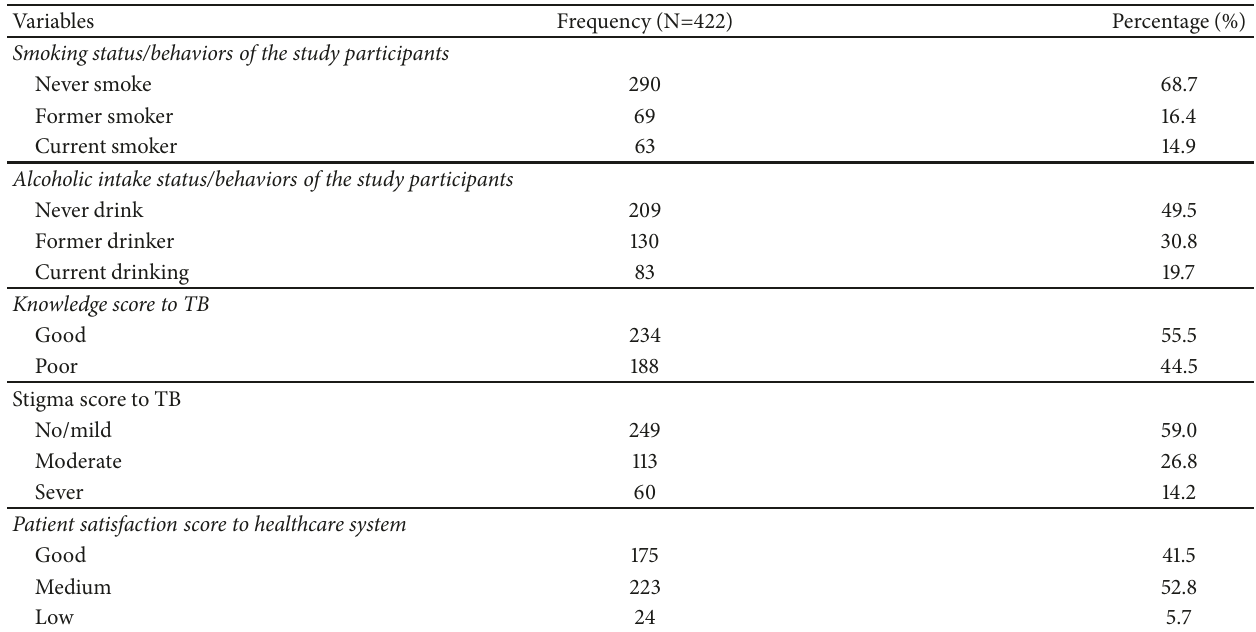
Table 3: Distribution of behavior related profiles among study participants in selected health facilities of Gedeo Zone, Southern Ethiopia, 2017/18.